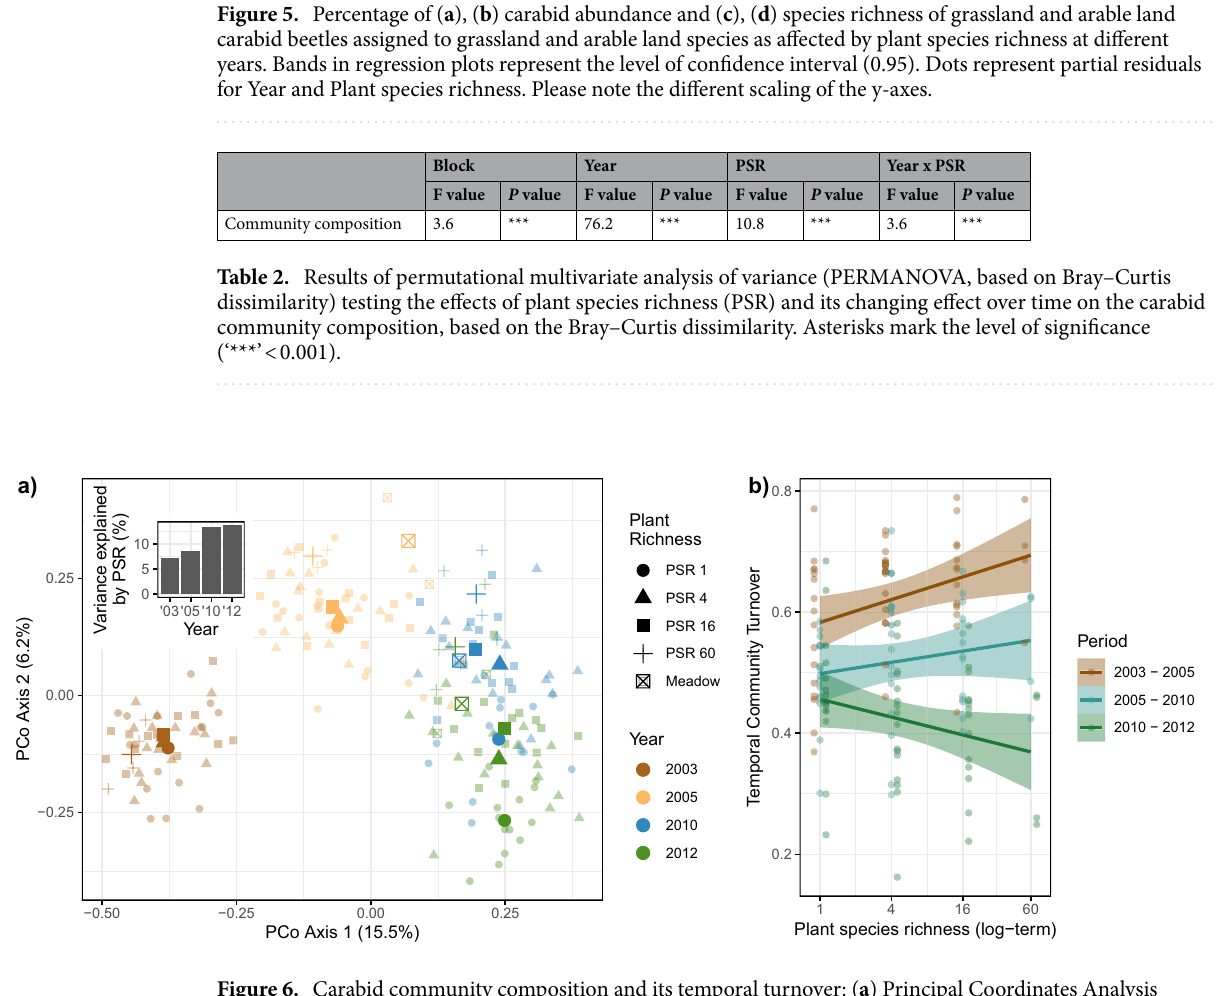
Figure 6. Carabid community composition and its temporal turnover: ( a ) Principal Coordinates Analysis (PCoA) based on species abundances in each plot in each year. The bar graph within this ordination plot gives the explained variance of the community by plant species richness (PSR) on an annual basis (see SI). Please note in the PCoA plot the carabid communities sampled in adjacent meadows that serve as reference. ( b ) Temporal community turnover, calculated from species abundances in a plot in two adjacent years, as a function of plant species richness. Bands represent the level of confidence interval (0.95). Small symbols in ( a ) represent single observations and large symbols the centroid per Plant species richness in each Year and in ( b ) dots represent partial residuals for Year and Plant species